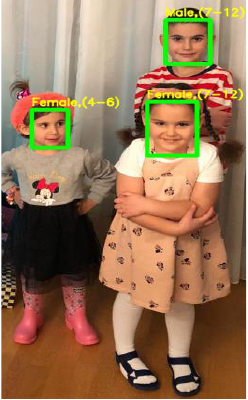
Fig. 9. The age and gender classification of two girls and a boy via CNN